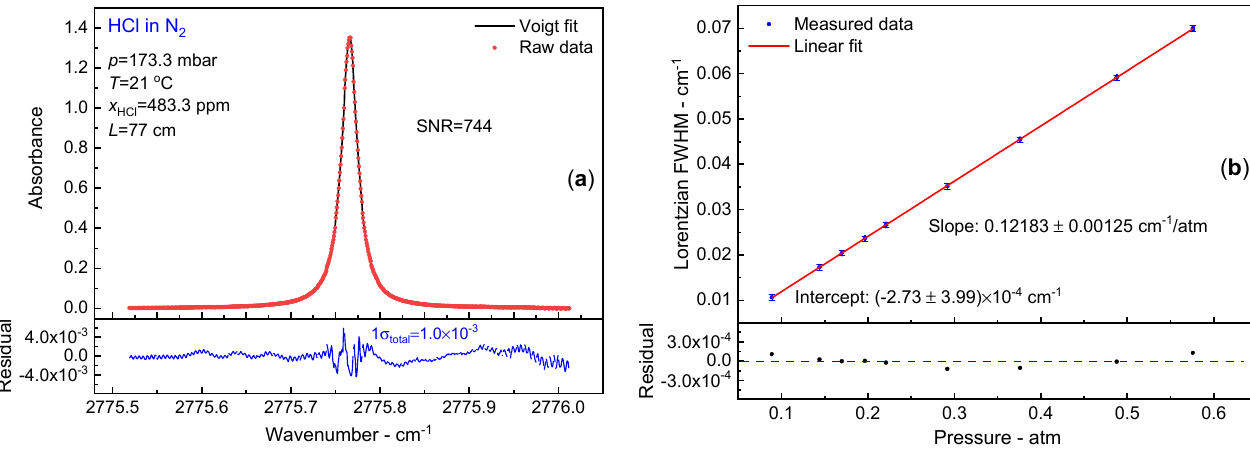
Figure 3. ( a ) Measured N 2 -broadened HCl absorption spectra at 173.3 mbar, and the fitting residual; ( b ) Measured N 2 induced pressure broadening with a linear fitting model. The residual between fit and data is shown below.